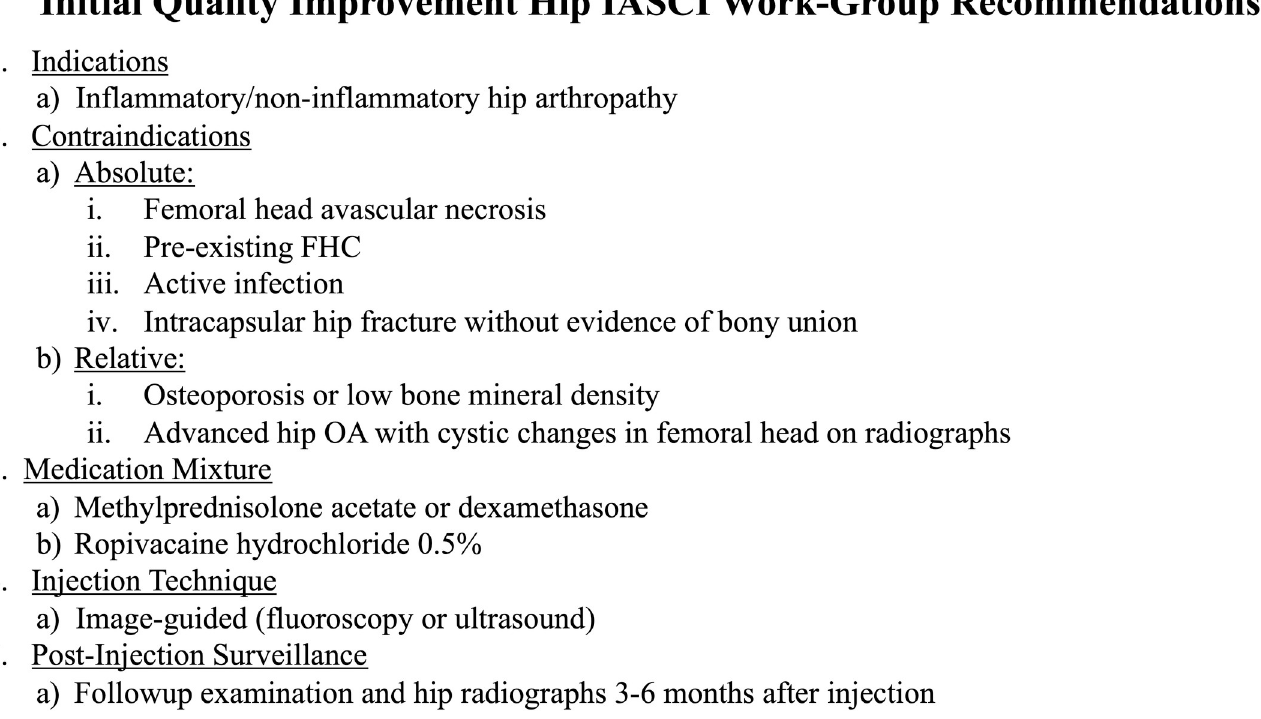
Fig 2. Initial informal hip IACSI treatment guidelines derived by multidisciplinary work-group.